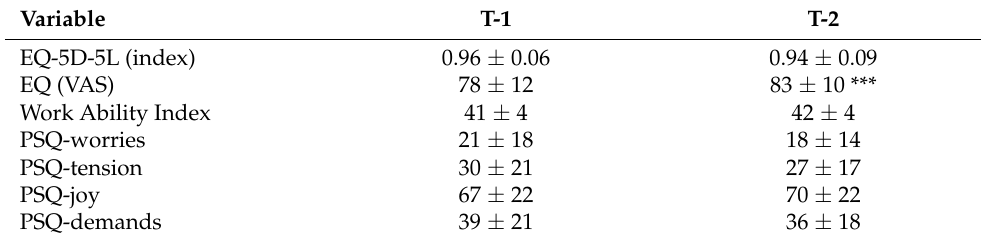
Table 3. Mean values and standard deviations (SD) of participants’ (N = 71) self-reported outcomes at baseline (T-1) and post-intervention